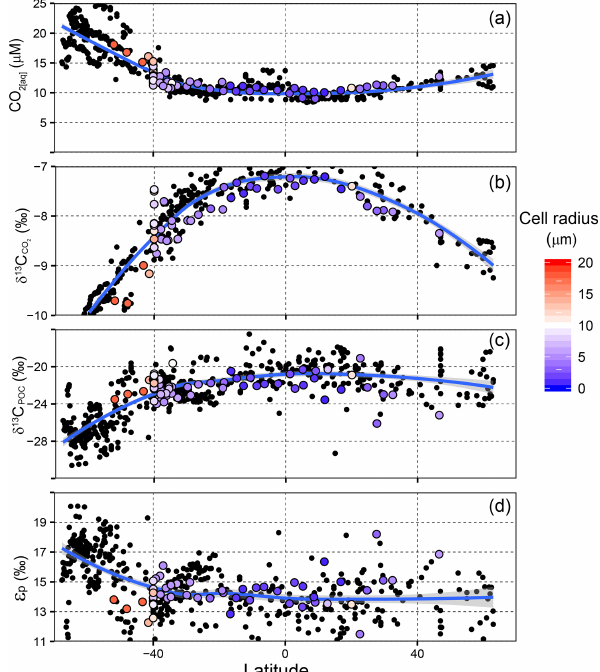
Figure 8. Global distributions of (a) [CO 2 ( aq ) ], (b) δ 13 C CO δ 13 C POC and (d) ε p in surface waters, plotted against latitude. Data include samples from the δ 13 C POC compilation in Young et al. (2013) and data from this study. Coloured points show cell ra- dius estimates (AMT3, AMT18 and this study). Blue lines in each panel show a loess fitted curve for the